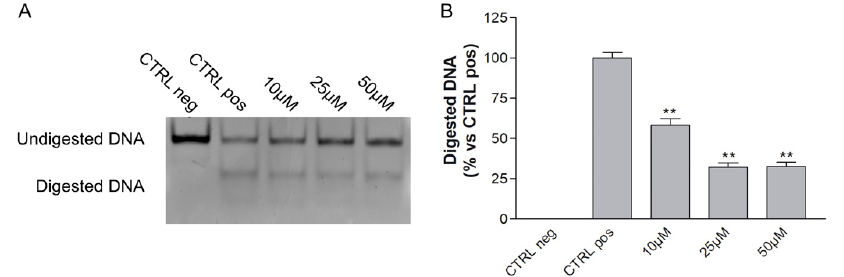
Figure 3. Representative image ( A ) and quantification graph ( B ) of ALKBH2 cell-free activity assay. Negative CTRL without ALKBH2 protein, positive CTRL with ALKBH2 protein and without treat- ments, increasing concentrations of MV1035 (10, 25, and 50 µ M). Data are represented as the mean percentage ± SD compared to untreated controls, arbitrarily set to 100%. ** p < 0.01 vs.